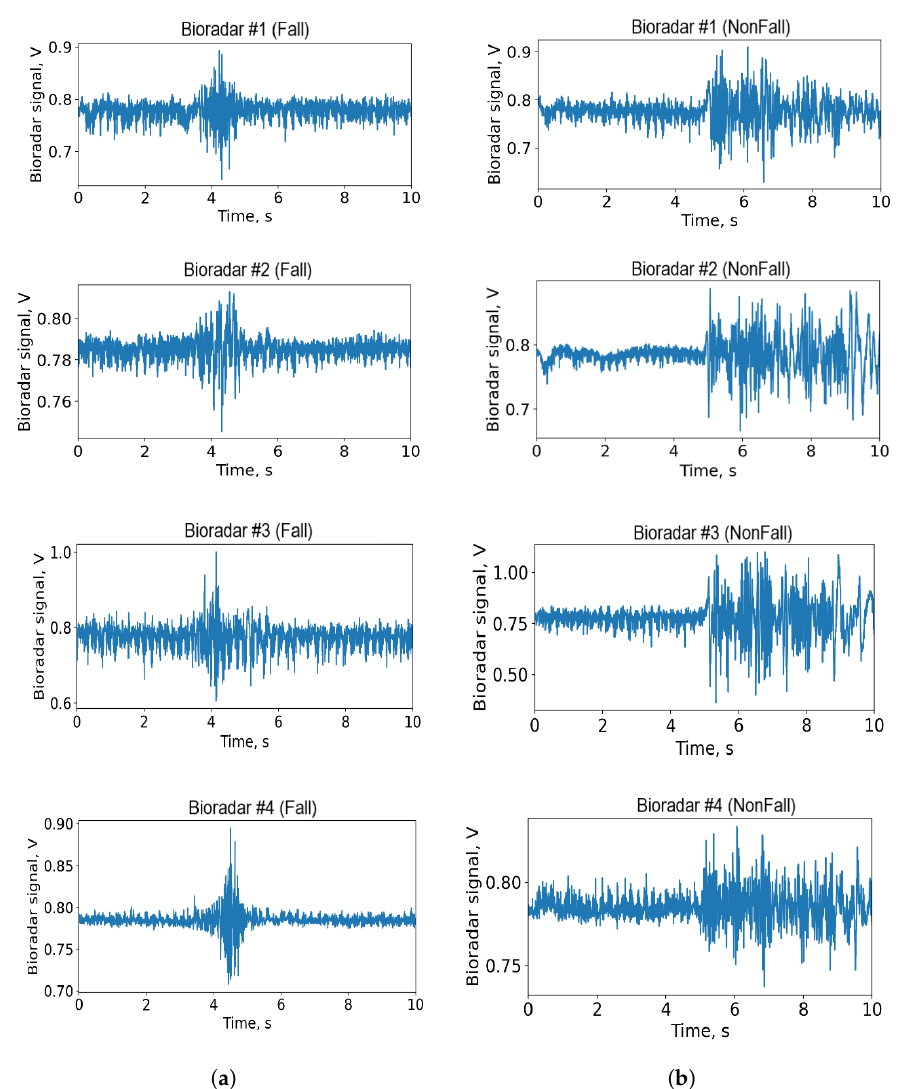
Figure 4. Examples of the preprocessed signal. ( a ) The fall event. ( b ) The squatting episode.